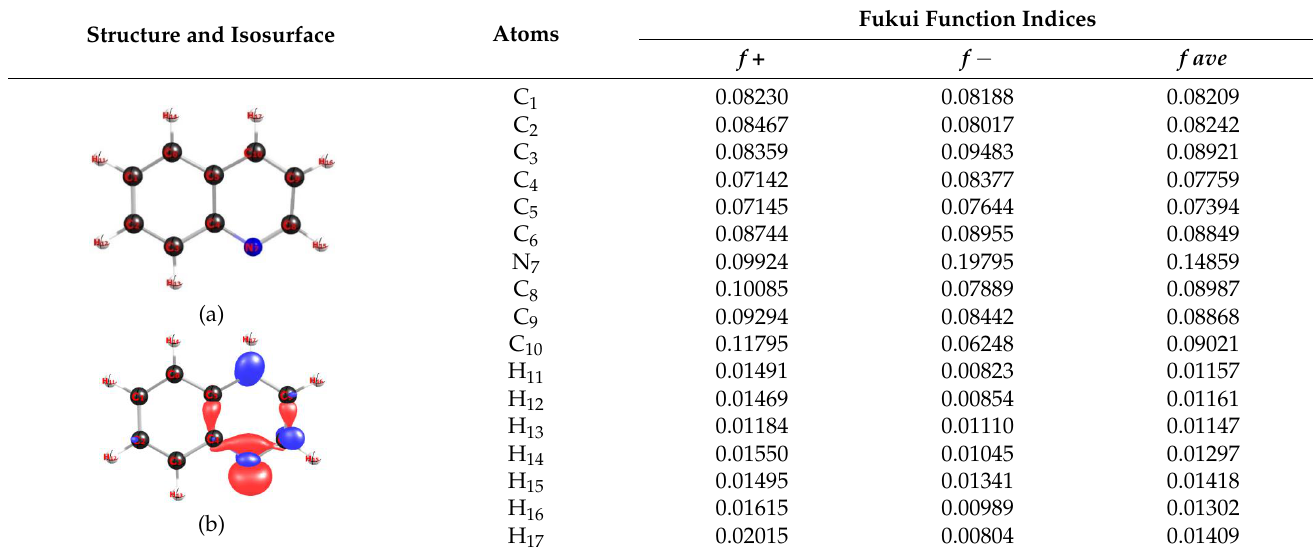
Table 1. Results of computational analysis for quinoline.